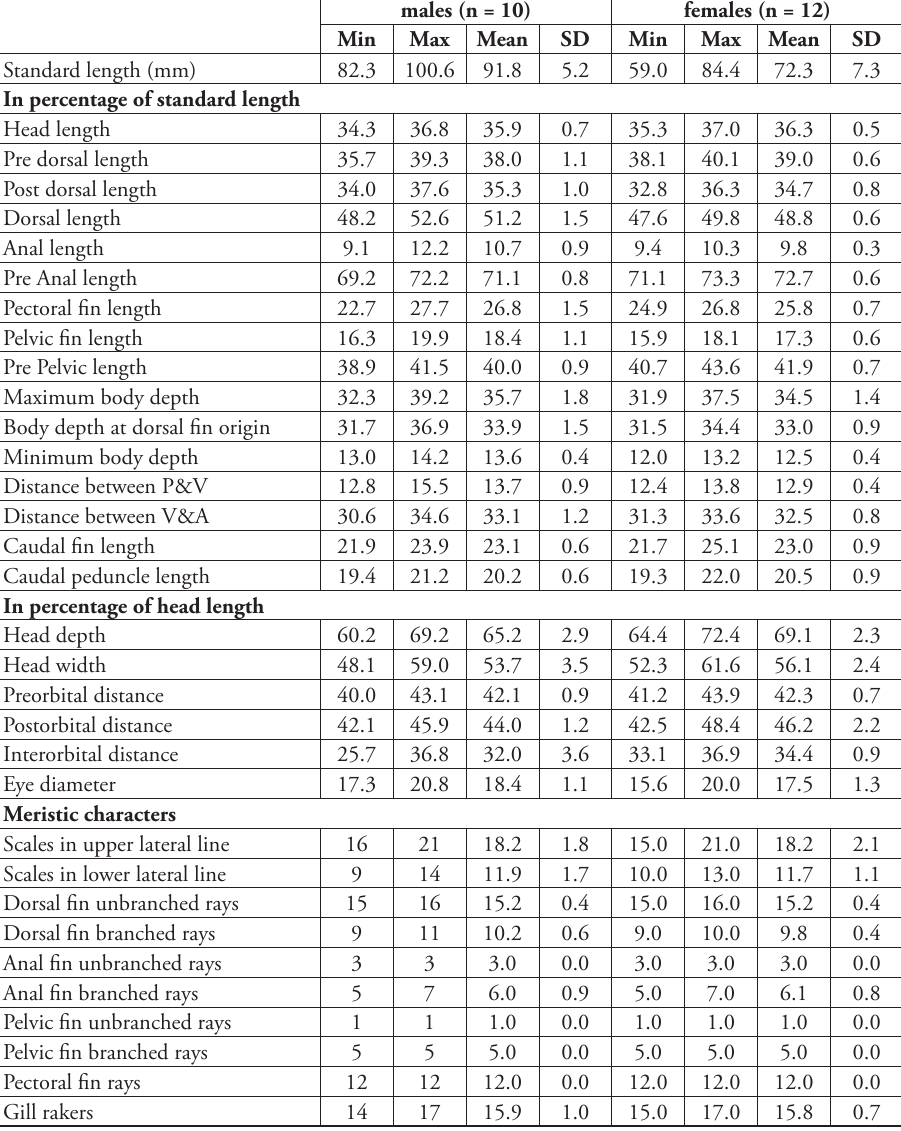
Table 3. Morphometric and meristic data of Iranocichla hormuzensis from Mehran River (ZM-CBSU K1128-K1143, IH2-IH7, n =